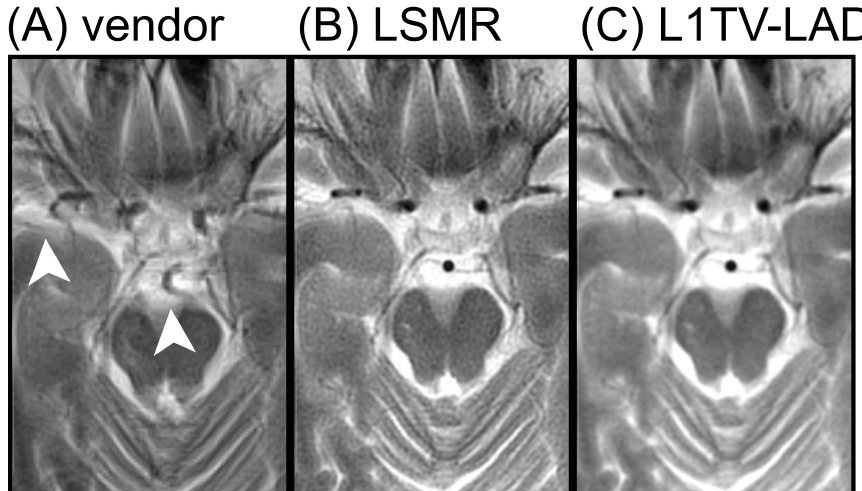
Figure 6. BLADE MRI with cooperative patients. ( A ) Erroneous correction for motion in the vendor- provided reconstruction, where the basilar artery is distorted and brain structures are overshadowed by artifacts (arrow heads). ( B ) Least-squares reconstruction without correcting motion. ( C ) L1TV-LAD reconstruction without correcting motion shows smooth imagery with a lower level of